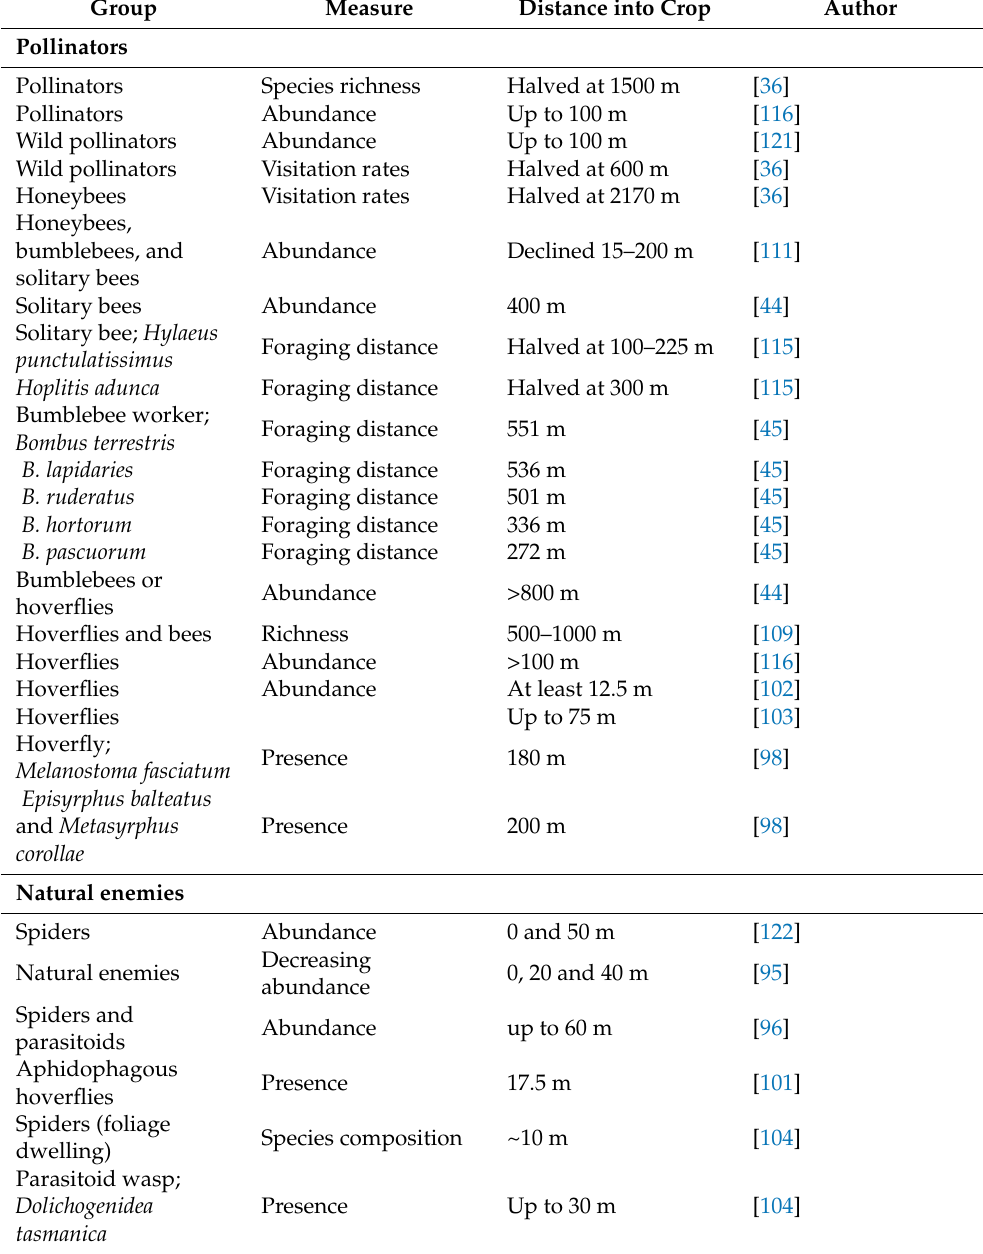
Table 1. Distance of spill-over of pollinators and natural enemies from floral resources and the seminatural habitat of importance to fruit